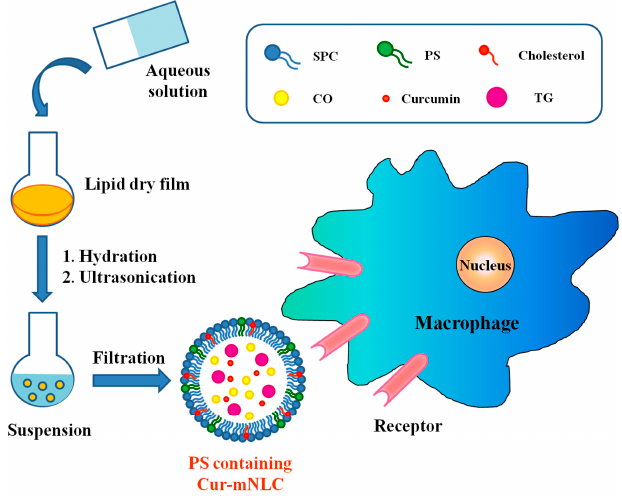
Figure 1. A schematic diagram of preparation procedures of PS-based nanoparticles and of endocytotic uptake by RAW 264.7 macrophages.